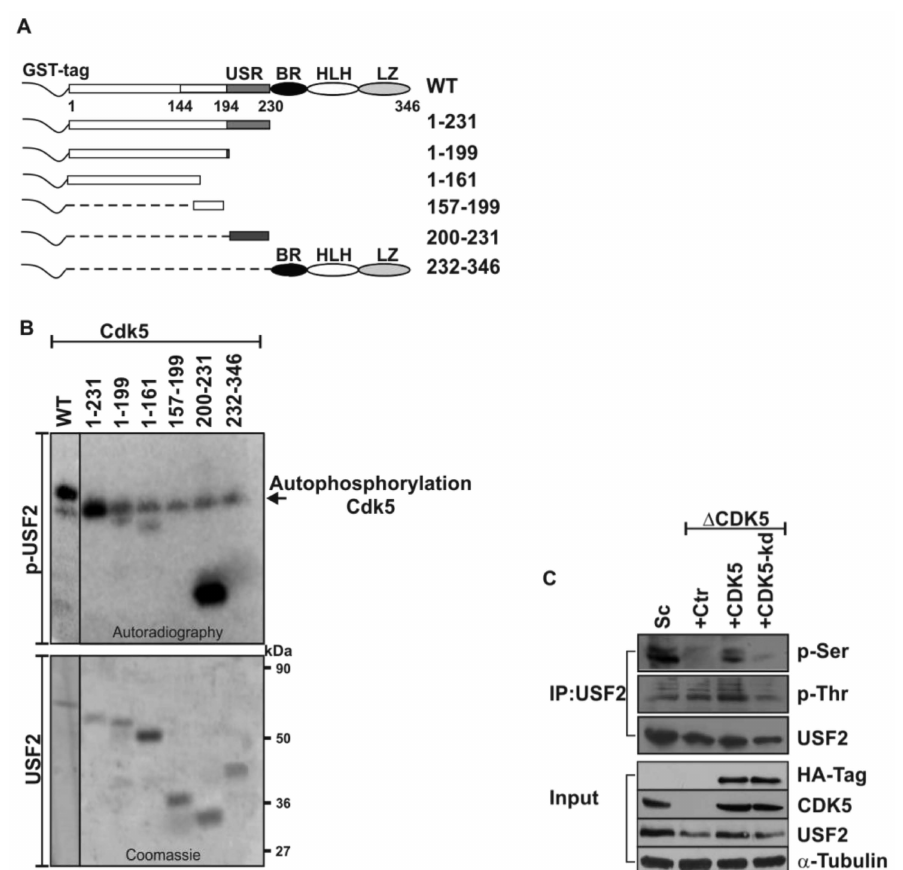
Figure 1. CDK5 phosphorylates USF2. ( A ) Scheme of USF2, its domains and deletion mutants that were cloned, expressed, and purified as GST fusion proteins. ( B ) Purified GST-tagged full-length USF2 and its deletion mutants were phosphorylated with recombinant human CDK5 (upper panel) in the presence of [32P]- γ -ATP for 20 min at 30 ◦ C. Proteins were separated by 10% SDS-PAGE and radioactivity was detected by autoradiography. The bands corresponding to the phosphorylated proteins (1–231) and (1–199) were partially covered by auto-phosphorylated Cdk5. Attempts to separate the bands by using 7.5% or 12% SDS-PAA gels were not successful. The lower panel shows the Coomassie staining performed as a loading control. ( C ) Endogenous USF2 was immunoprecipitated from control (Sc), ∆ CDK5 PC3 cells and ∆ CDK5 cells transfected with a plasmid encoding wild-type or kinase-dead CDK5; phospho-USF2 protein levels were detected with phospho-threonine or phospho-serine